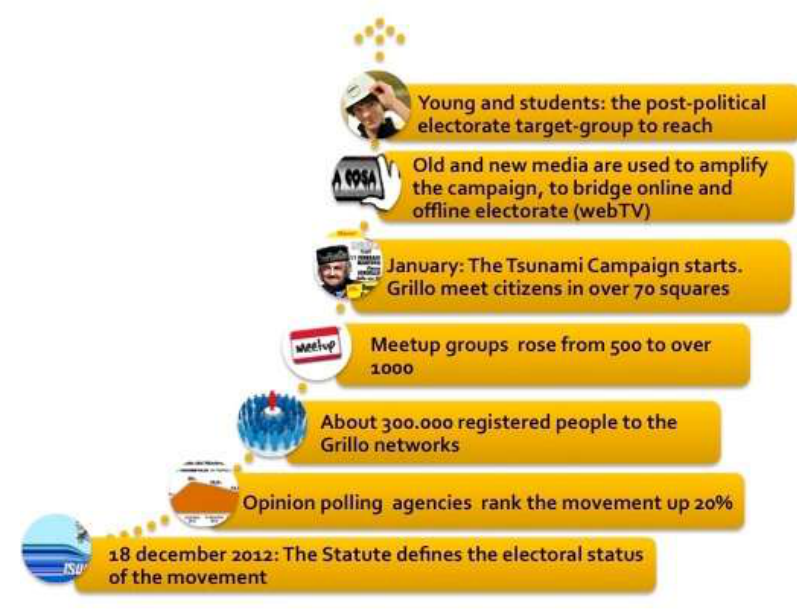
Figure 4: The Tsunami Tour A month before the elections, the number of MeetUps started to increase, going from just over 500 in November to over 708 in early January and soaring to 1,102 groups in March 2013 (an increase of over 32 groups per week). Apart from the MeetUps, many of which constituted four thousand members, there were also smaller groups with a few dozen members. If we look at the MeetUp list (http://beppegrillo.meetup.com), we can see that the Movement is actually very far- reaching, with a network that branches out over large areas yet concentrated in local points